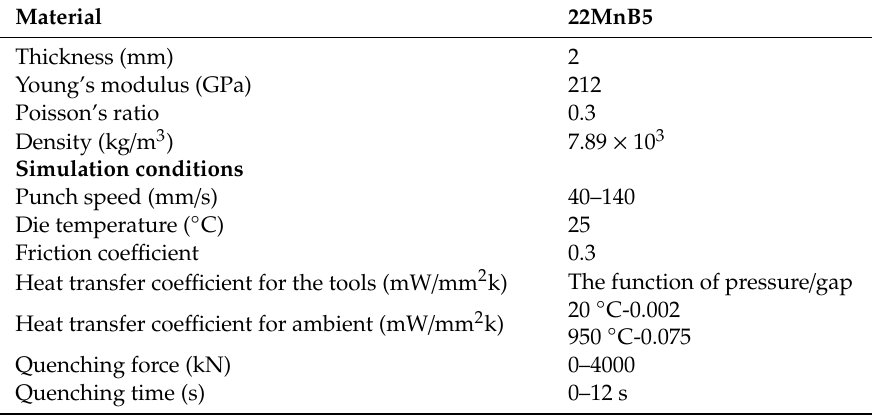
Table 1. Material properties and simulation conditions.